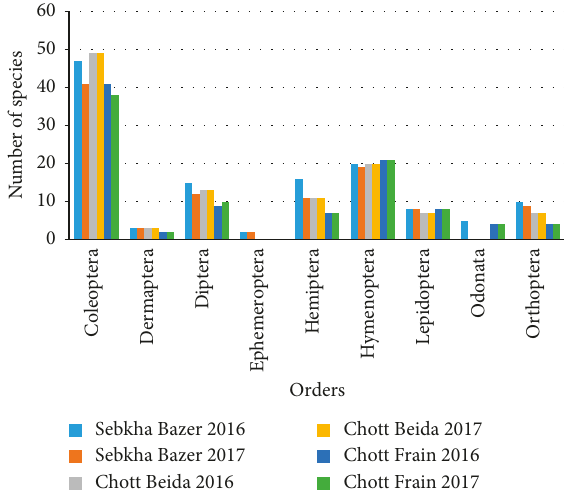
4: Number of insect taxa in all collected studied sites of three saline wetlands during study period